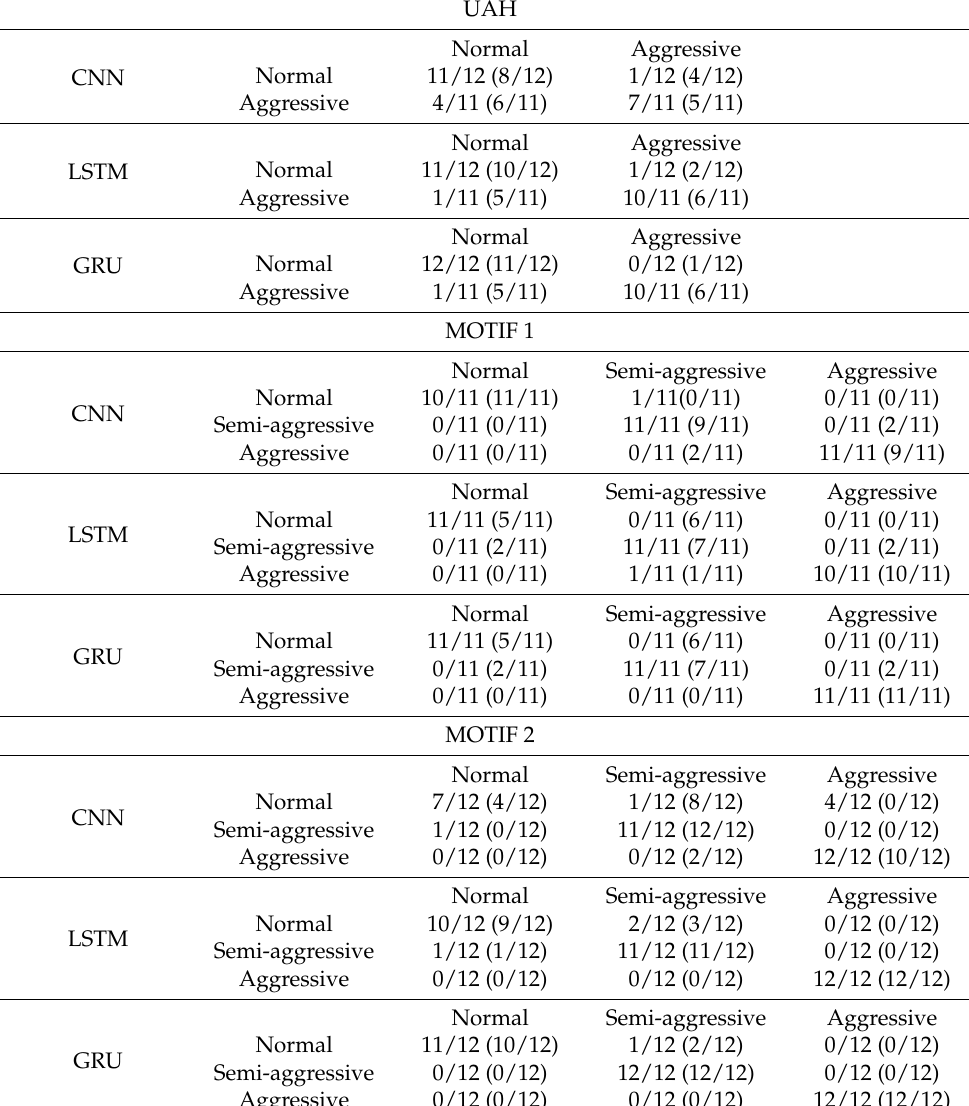
Table 6. Confusion matrices for route level classification (NN-only result in